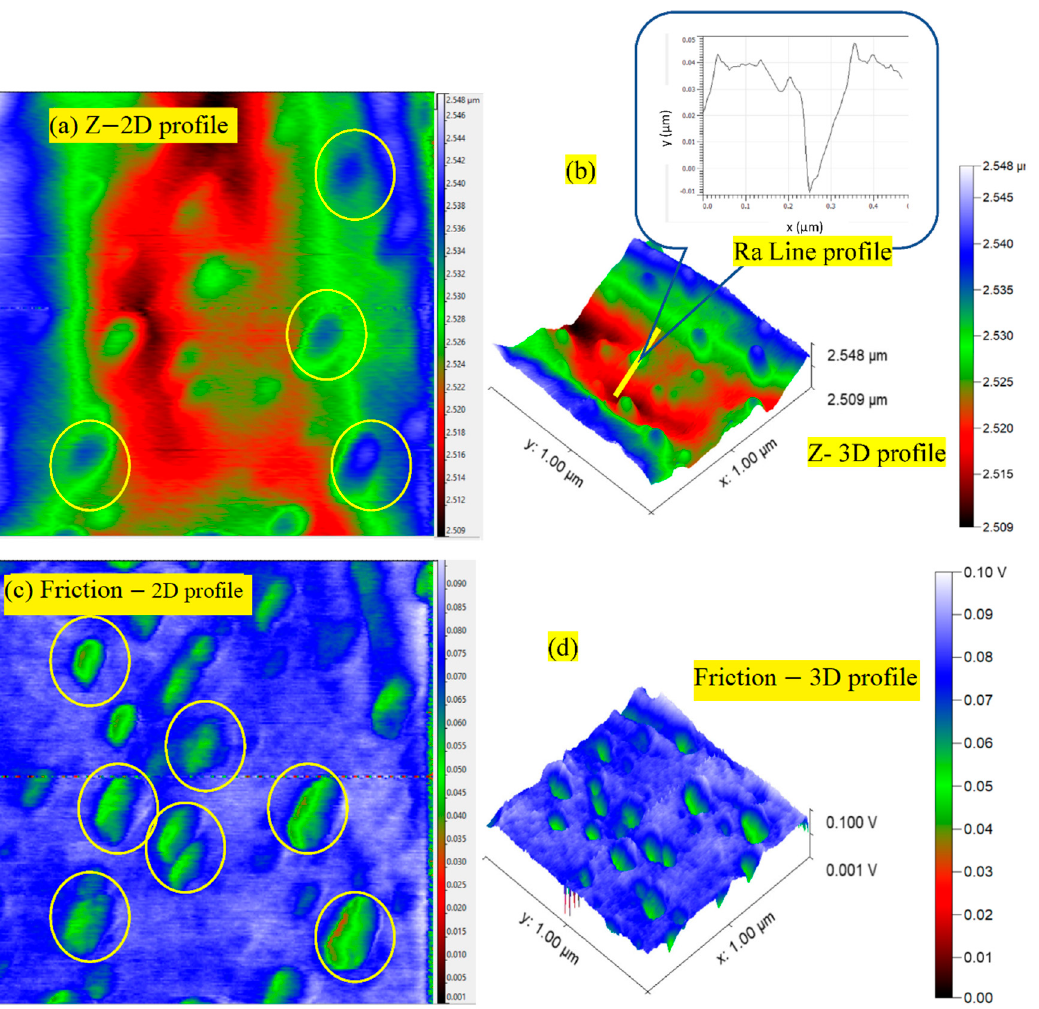
Figure 14. ( a , b ) Z-profiles (2D and 3D) and ( c , d ) friction profiles in 2D and 3D forms for the worn pin of composite T slid at 300 N, 1 m/s (scanning area of 1 µm × 1 µm).